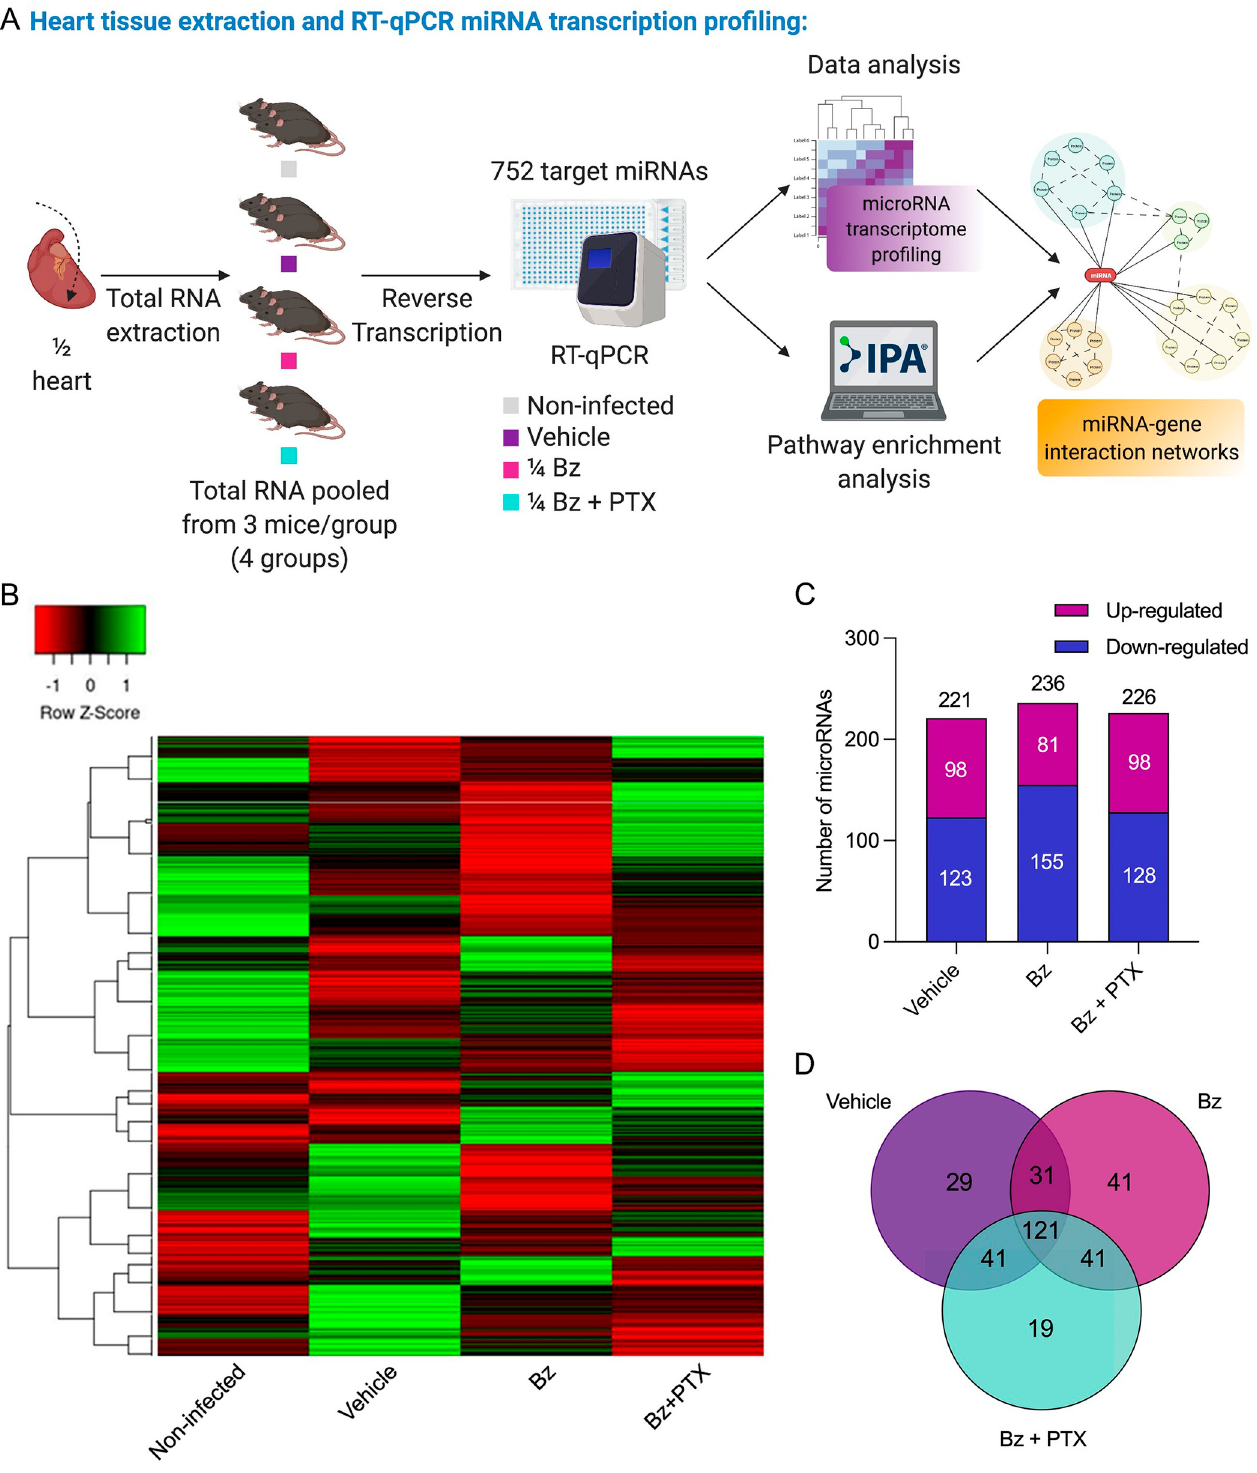
Fig 2. Overview and characterization of immunoarray analysis. (A) Schematic design of array workflow. Murine cardiac tissues were harvested 30 days after therapy and half of the heart was subjected to total RNA extraction, reverse transcription, and RT-qPCR of 752 miRNAs. Created with Biorender. (B) Heatmap and hierarchical clustering. The color scale illustrates the gene fold change after global normalization (row Z-score). Clustering was performed using the average linkage distance measurement method: Spearman Rank correlation. (C) Number of altered genes in each group. (D) Venn diagram showing the number of altered expressed genes in each